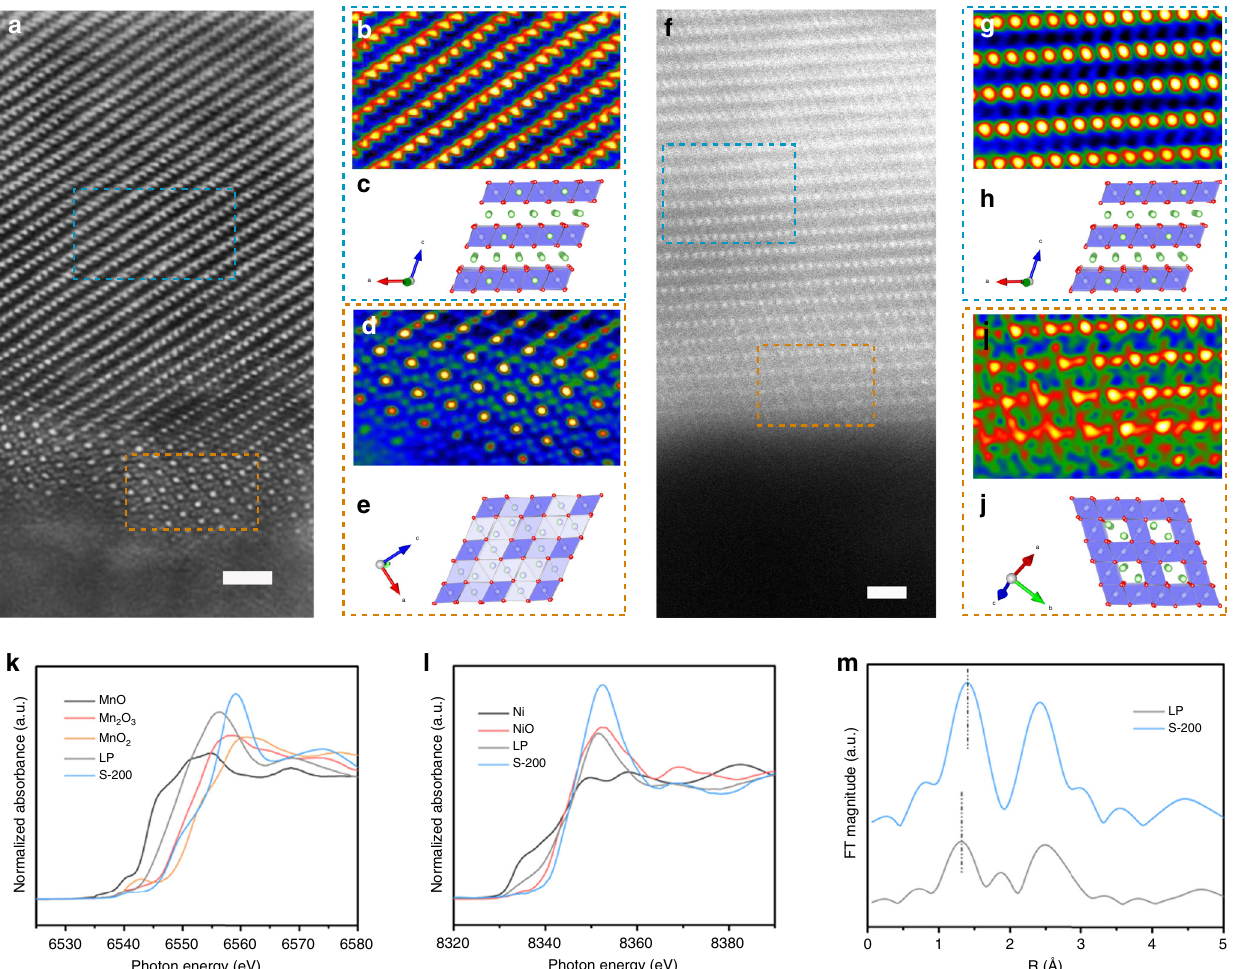
Fig. 6 The atomic structural evolution and oxidation-state change of samples before and after cycling. a – e Atomic con fi guration of the S-200 before cycling. The overview of HAADF-STEM image ( a ) shows the crystal structure from surface to the bulk of S-200; the blue and orange dash square showed two regions with different atomic con fi gurations. The interior region marked by the blue dashed square in ( a ) has been FFT- fi ltered and shown in ( b ), and the corresponding atomic model is shown in ( c ). The spots with higher contrast in ( b ) show TM ions with higher Z than Li ions; the Li, M, and O ions have been shown as green, blue, and red spheres in ( c ), respectively. The surface region with cation-mixed Mn 3 O 4 feature marked by orange dash square in ( a ) has been FFT- fi ltered and shown in ( d ), and the corresponding atomic model has been drawn ( e ) . f – j The atomic con fi guration of S-200 electrode after 100 cycles. The HAADF-STEM image from the surface to the bulk of charged S-200 ( f ) shows the different atomic con fi gurations on the surface area; the blue and orange dashed square shows two regions with different atomic con fi gurations. The layered feature region marked by the blue dashed square in ( f ) has been FFT- fi ltered as shown in ( g ), and the corresponding atomic model is shown in ( h ). The region with a spinel feature that is marked by an orange dashed square in ( f ) has been FFT- fi ltered and shown in ( i ), and the corresponding atomic model is shown in ( j ). The scale bar donates 1 nm. k Normalized Mn K-edge XANES spectra of cycled LP and S-200. The valence states of Mn were determined by comparison with the spectra of pure-phase MnO, Mn 2 O 3 , and MnO 2 . l Normalized Ni K-edge XANES spectra of cycled LP and S-200. The valence states of Ni were determined by comparison against the spectra of pure-phase Ni and NiO. m The k 3 -weighted Fourier transform magnitudes of Mn K-edge EXAFS spectra obtained from cycled LP and